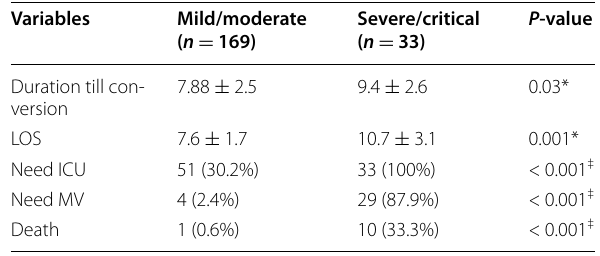
Table 5 Outcome of the studied COVID-19 patients